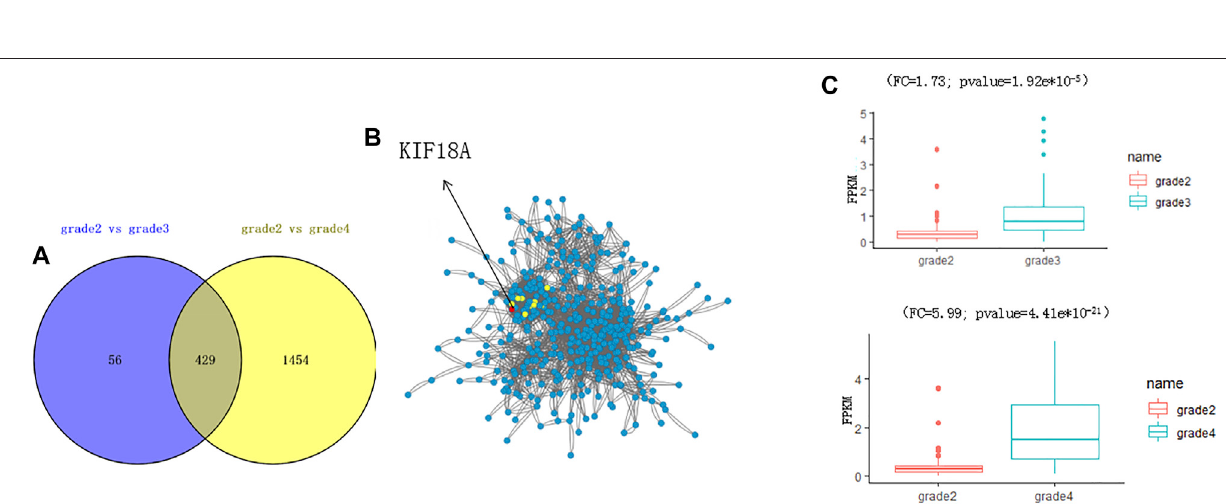
Frontiers in Genetics |